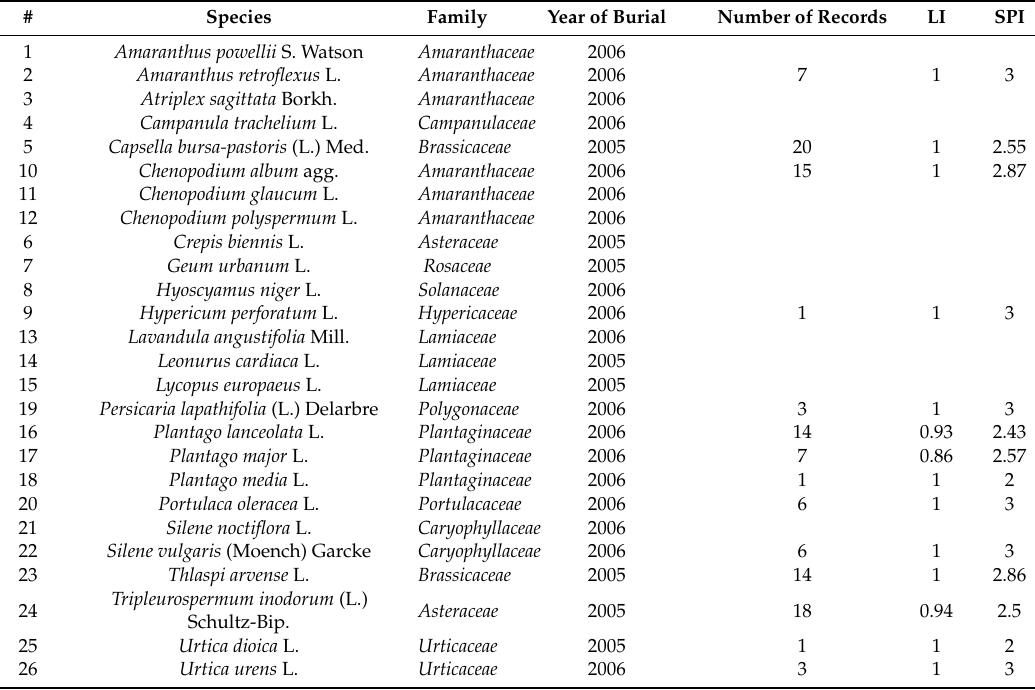
Table 1. Species of seeds buried in 2005 and 2006 with longevity index (LI) and seed persistence index (SPI) calculated based on the burial data taken from [2]. Number of records indicates how many individual data entries from the database of [3] were used for calculation of the indexes. The nomenclature was based on Kub á t et al.